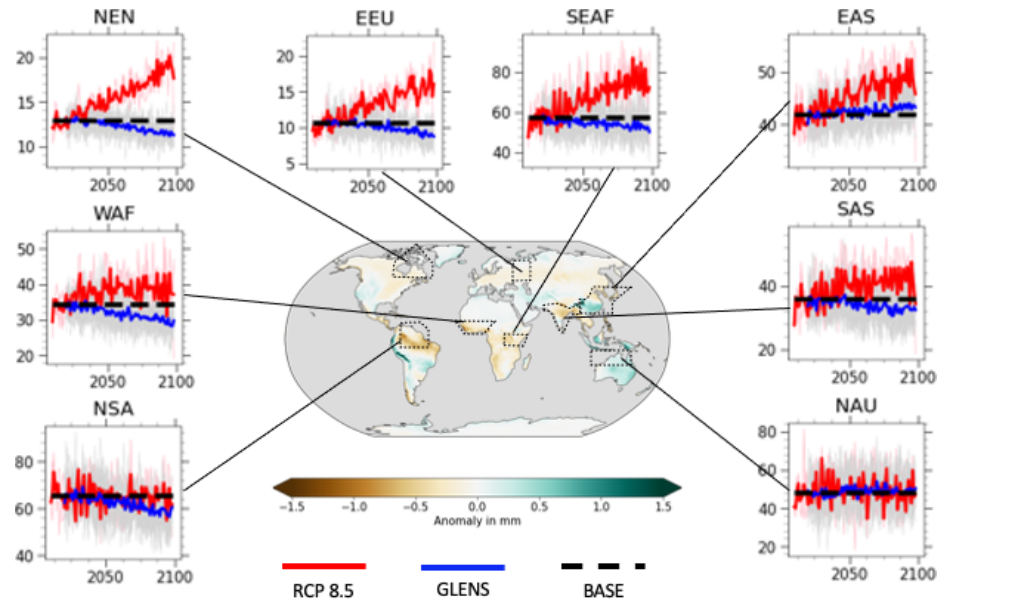
Figure 9. Ensemble mean of projected changes in mean daily precipitation for GLENS EC (2075–2095) minus BASE (2010–2030) with inset regional time series of frequency of days > 10mm (R10mm) for northeastern North America (NEN), northern South America (NSA), southeastern Africa (SES), western Africa (WAF), eastern Europe (EEU), South Asia (SAS), East Asia (EAS), and northern Australia (NAU). Regional time series comprise ensemble mean R10mm for GLENS EC minus BASE in thick blue and individual members in light gray, ensemble mean R10mm for RCP8.5 EC in thick red and individual members in light pink, and ensemble and climatological mean R10mm for BASE in thick dashed